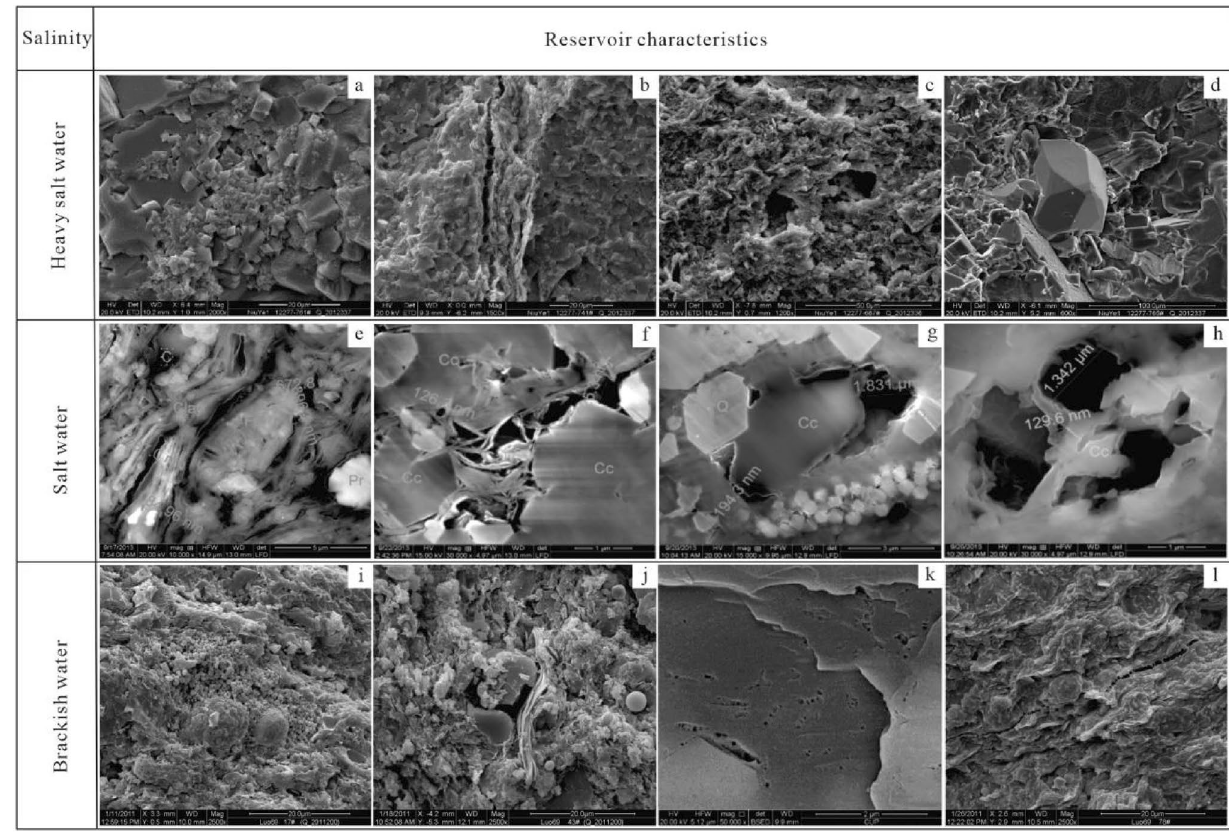
3717.80 m, intergranular pore, f Well Niuye 1, 3826.80 m, intergran- ular pore, g Well Niuye 1, 3762.95 m, corrosion pore, h Well Niuye 1, 3762.95 m, intergranular pore, i Well L 69, 2915.11 m, pyrite inter- granular pore, j Well L 69, 2922.20 m, intergranular pore, k Well Niu 38, 3350.00 m, boring pore; l Well L 69, 2939.11 m,